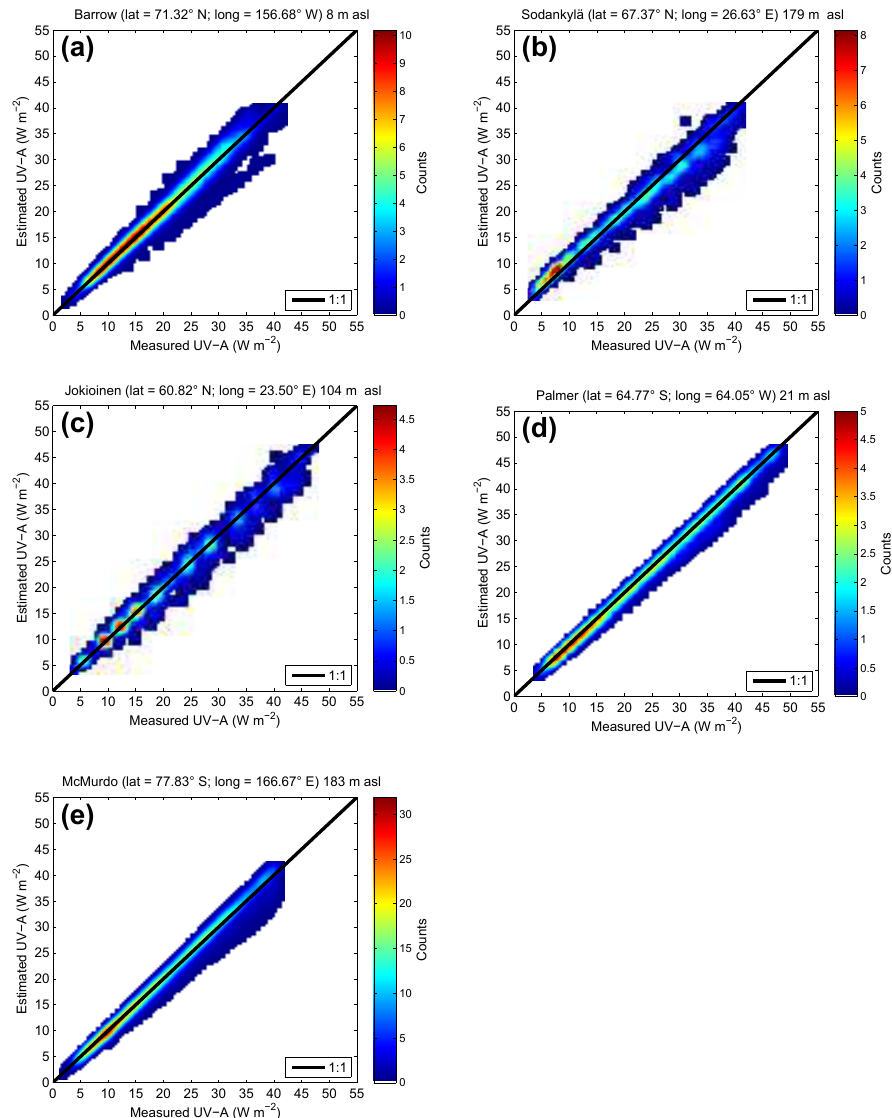
Figure 2. Scatter density plot between measurements of UV-A and estimates for each station with each station name at the top. The color bar indicates the number of points in the area within the interval 0.4Wm − 2 × 0.4Wm − 2 .